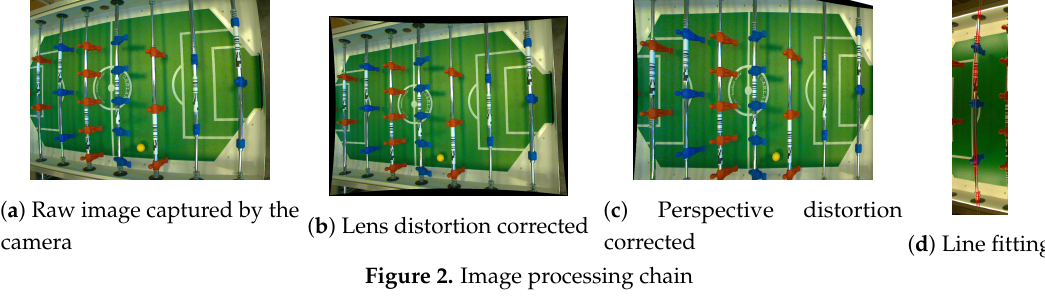
Figure 2. Image processing